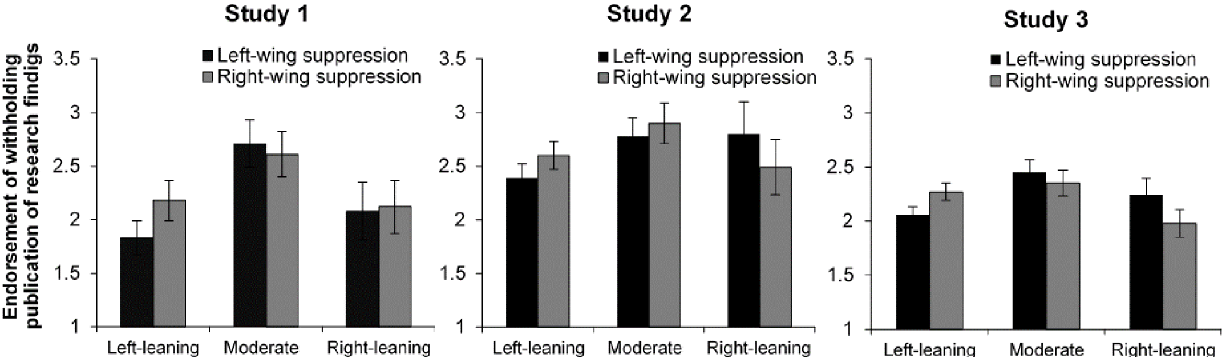
Figure 1. Endorsement of withholding the publication of research findings as a function of research suppression ( left-wing research suppression vs. right-wing research suppression ) and ideology (left-leaning vs. right-leaning vs. moderate participants). Higher values represent stronger endorsement of withholding the publication of research findings. Error bars denote one standard error above and below the